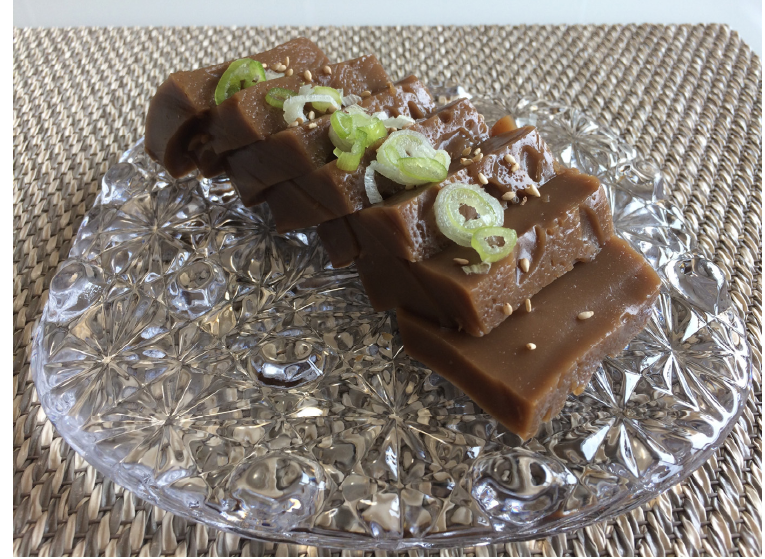
Figure A4. Ingredients: acorn powder, water, a bit of salt; see recipe at: http://www.maangchi.com/ recipe/dotorimukmuchim.